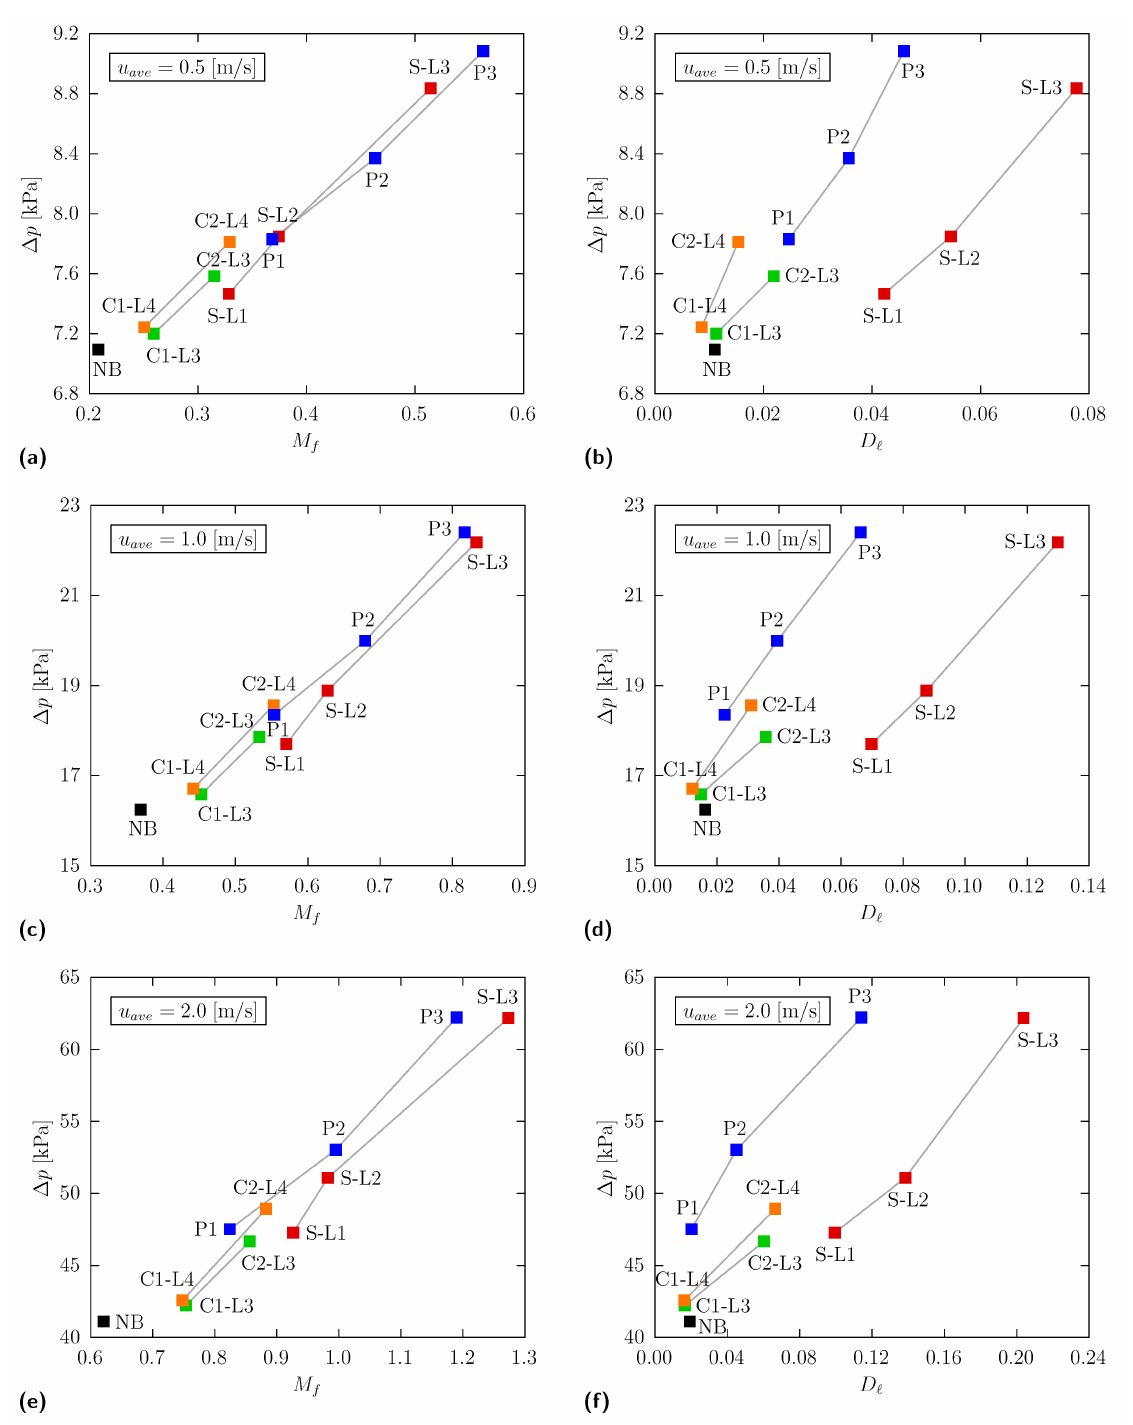
Figure 13. Performances of different heat-sink headers: ( a , c , e ) ∆ p vs. M f and ( b , d , f ) ∆ p vs. D (cid:96) , for different values of u ave